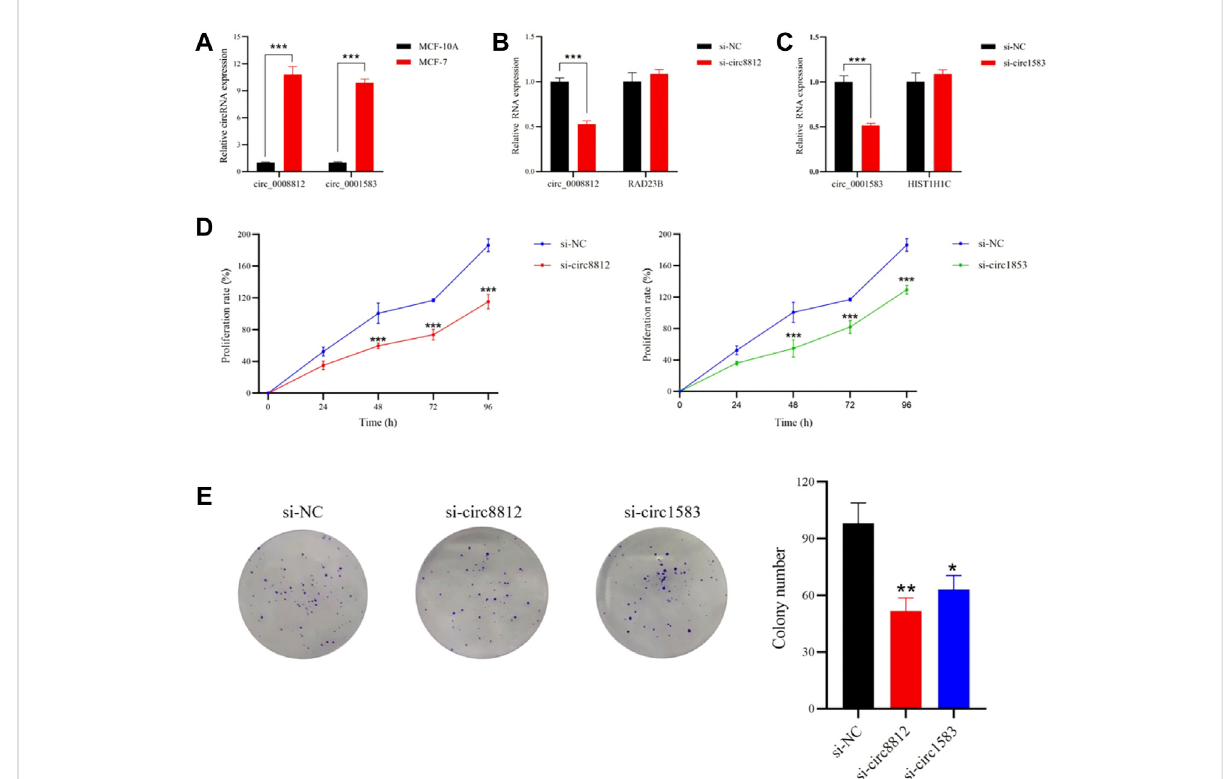
FIGURE 7 Circ_0008812 and circ_0001583 promoted MCF-7 Cell proliferation. (A) the expression of circ_0008812 and circ_0001583 was measured by qRT-PCR in MCF-10A and MCF-7 cell lines. (B,C) the expression levels of circ_0008812, circ_0001583 and thier parental genes in MCF-7 cells transfected with circ_0008812 and circ_0001583 siRNA. (D,E) the cell proliferation ability of MCF-7 cells treated with si-NC, si-circ8812 or si- circ1583 was detected by MTT and colony formation assay. The data are shown as mean ± SD of three independent experiments. * p < 0.05, ** p < 0.01, *** p <